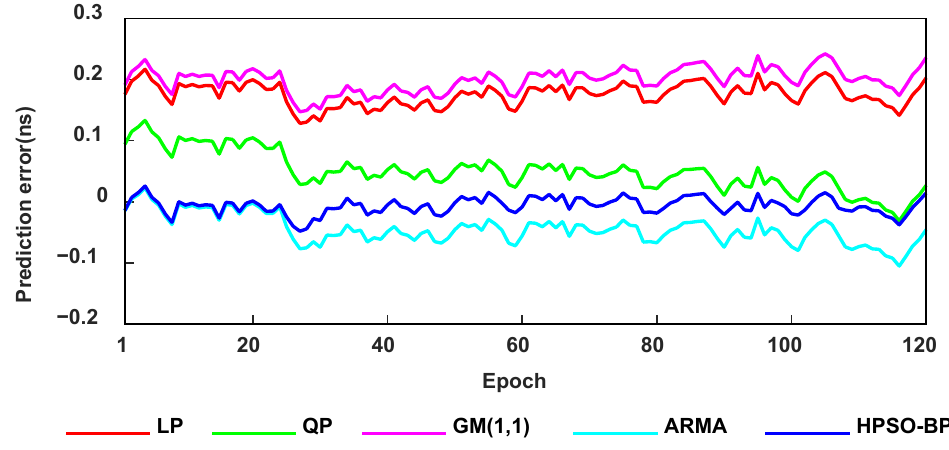
Figure 8. Prediction error of PRN10 by the five models.